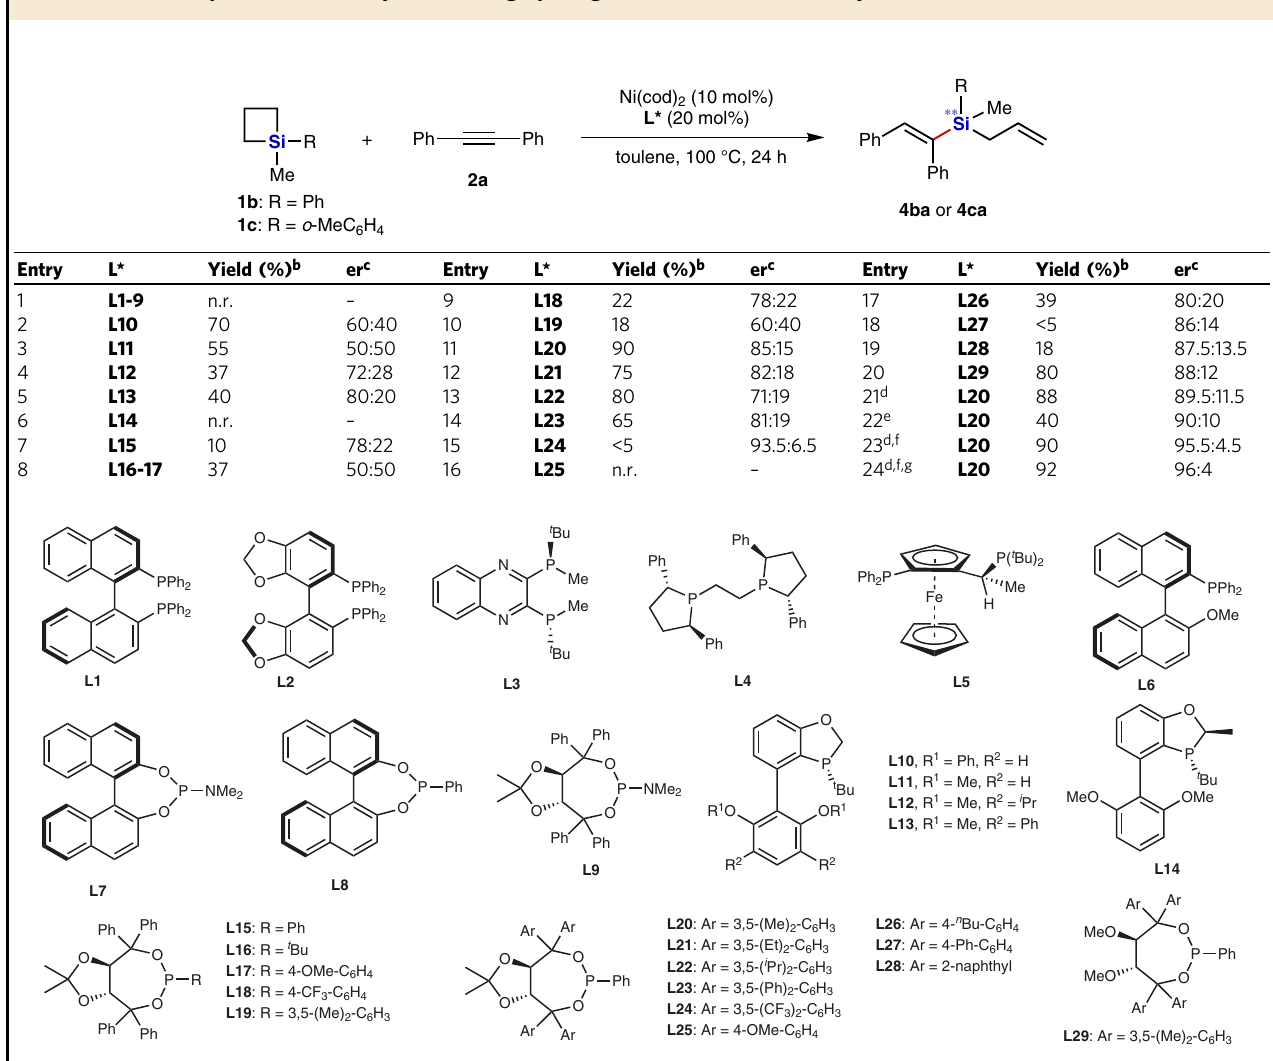
Table 3 Condition optimization for asymmetric ring-opening reaction of SCBs with alkyne 2a a